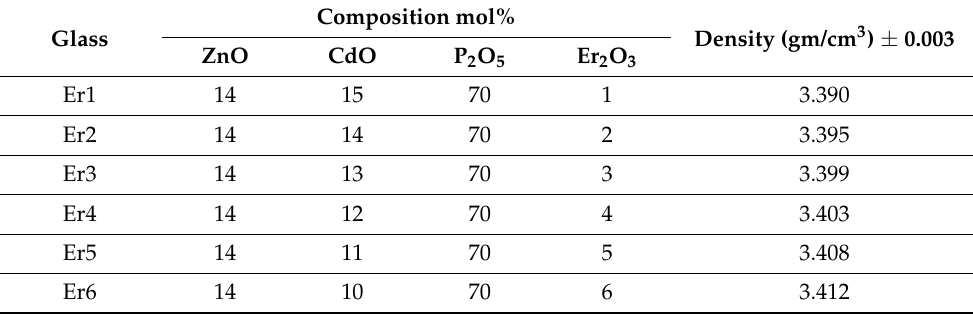
Table 1. Glasses code, composition, density of the prepared glasses (70P 2 O 5 )–(16 − x)CdO–(14ZnO)– (xEr 2 O 3 ), (x = 1–6